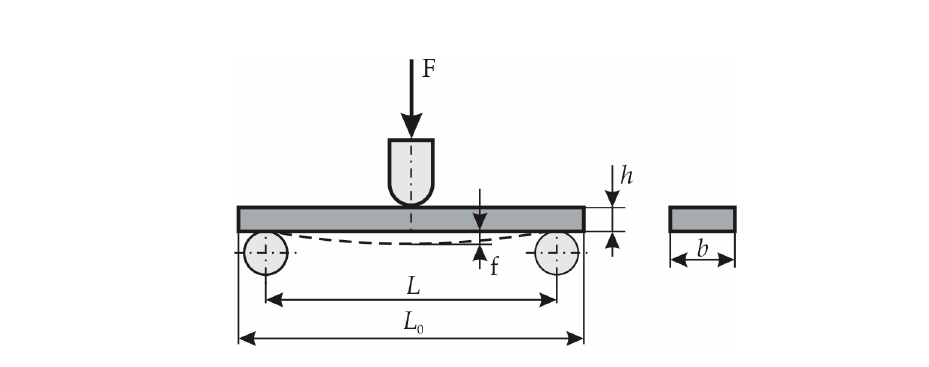
Figure 4. Bending test (three point’s method).